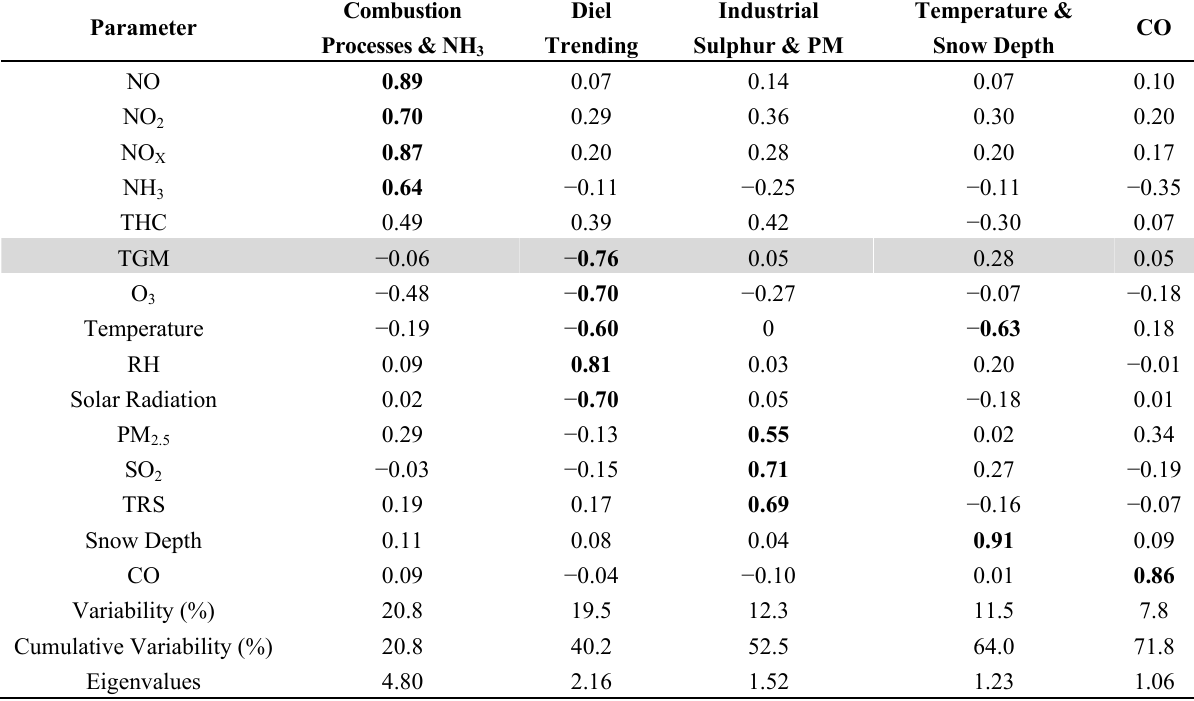
Table 3. PCA rotated factor loadings for the middle 1/3rd of de-trended/seasonally adjusted TGM concentrations ( i.e ., “average” TGM concentrations). Factor loadings with an absolute value greater than or equal to 0.5 are bolded. The shaded row highlights TGM loadings on each